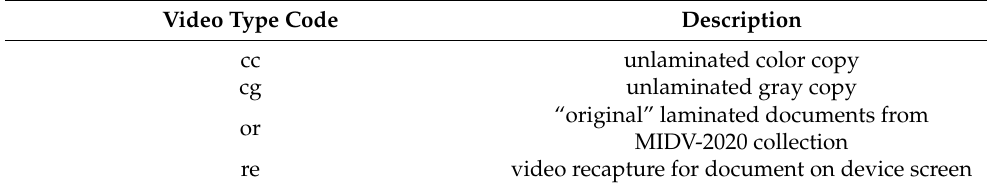
Table 2. Types of